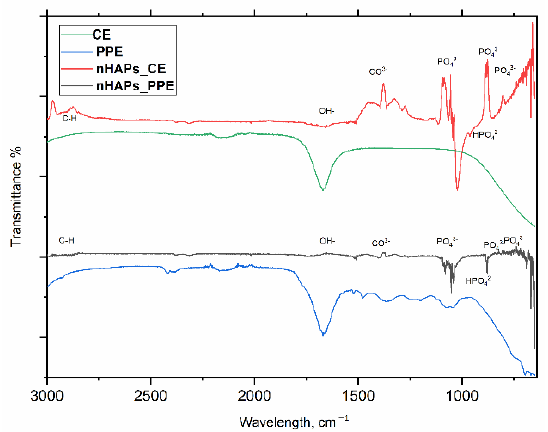
Figure 4. FTIR spectra of the green synthesized nHAPs_PPE and nHAPs_CE.